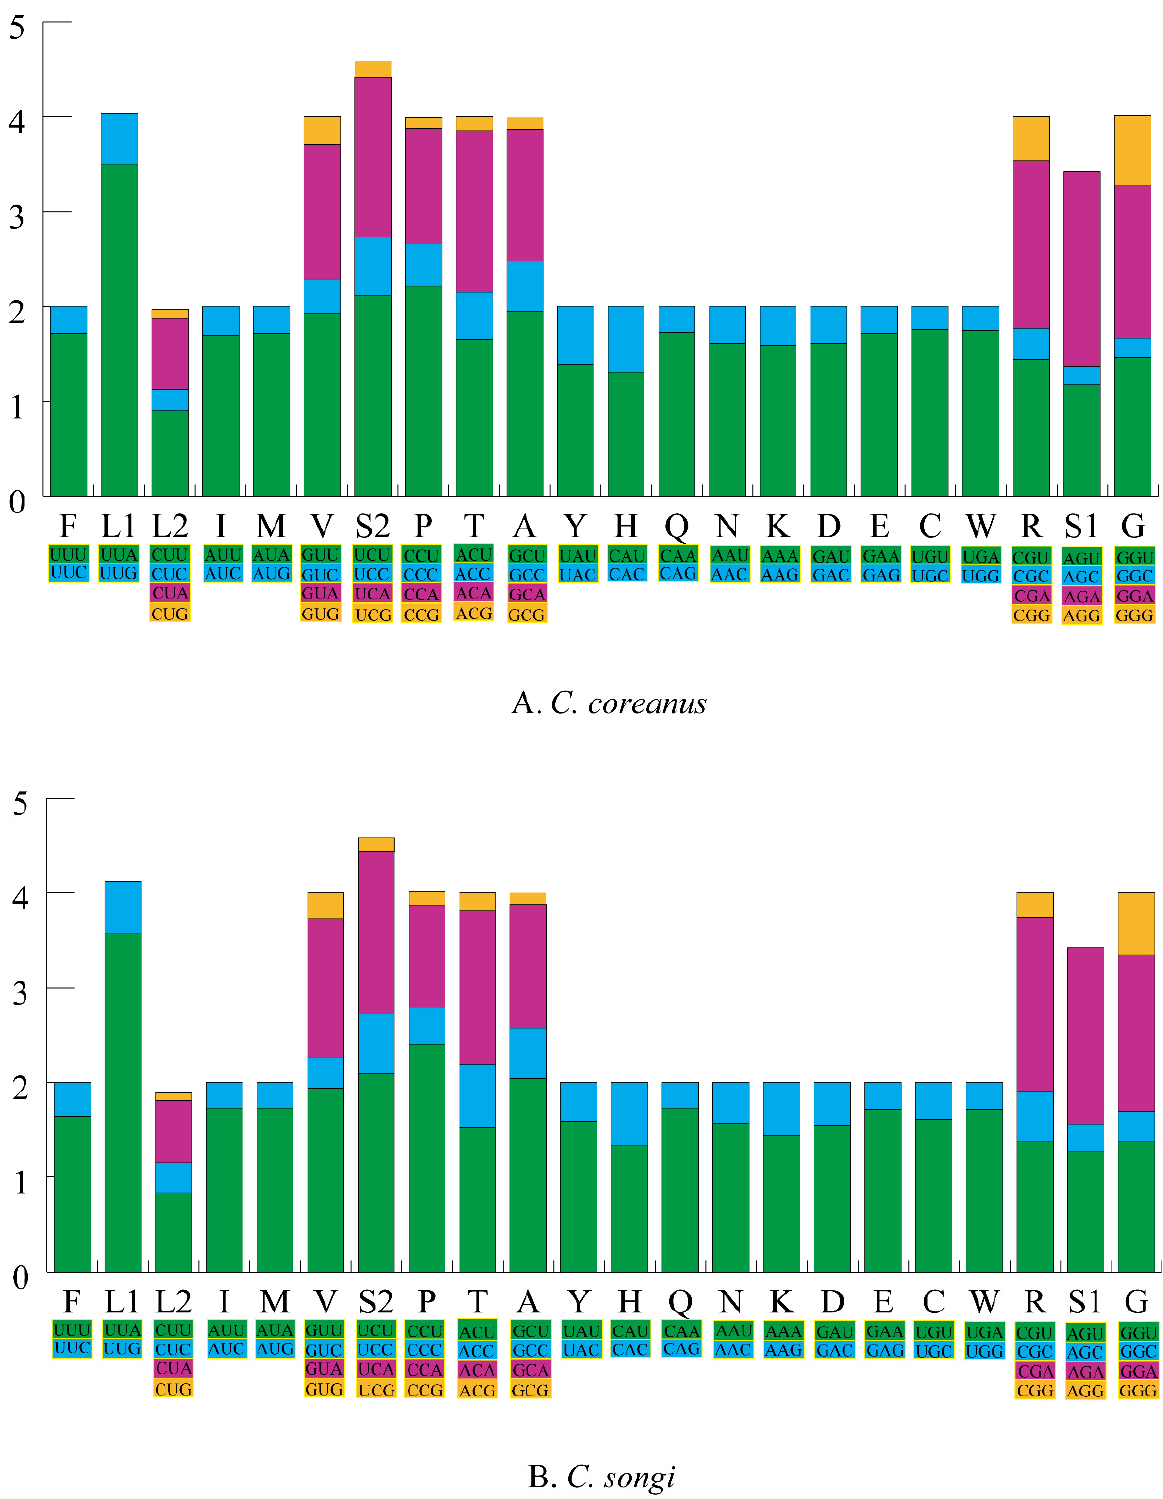
Figure 2. The relative synonymous codon usage (RSCU) in two Microcoryphia mitogenomes. Codon families are provided on the x-axis and the different combinations of synonymous codons that code for each amino acid are defined on the y-axis.